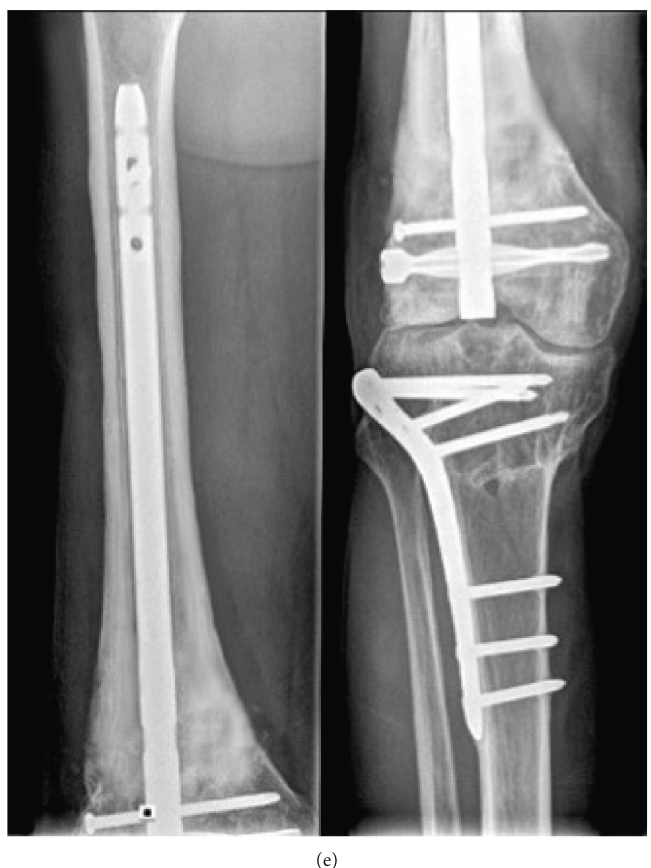
Figure 2: (a, b) Preoperative nonunion. (c, d) Six-month postoperative nonunion treated with replating with a new nonunion. (e) Twelve- month postoperative nonunion of the replating treated with a retrograde nail.